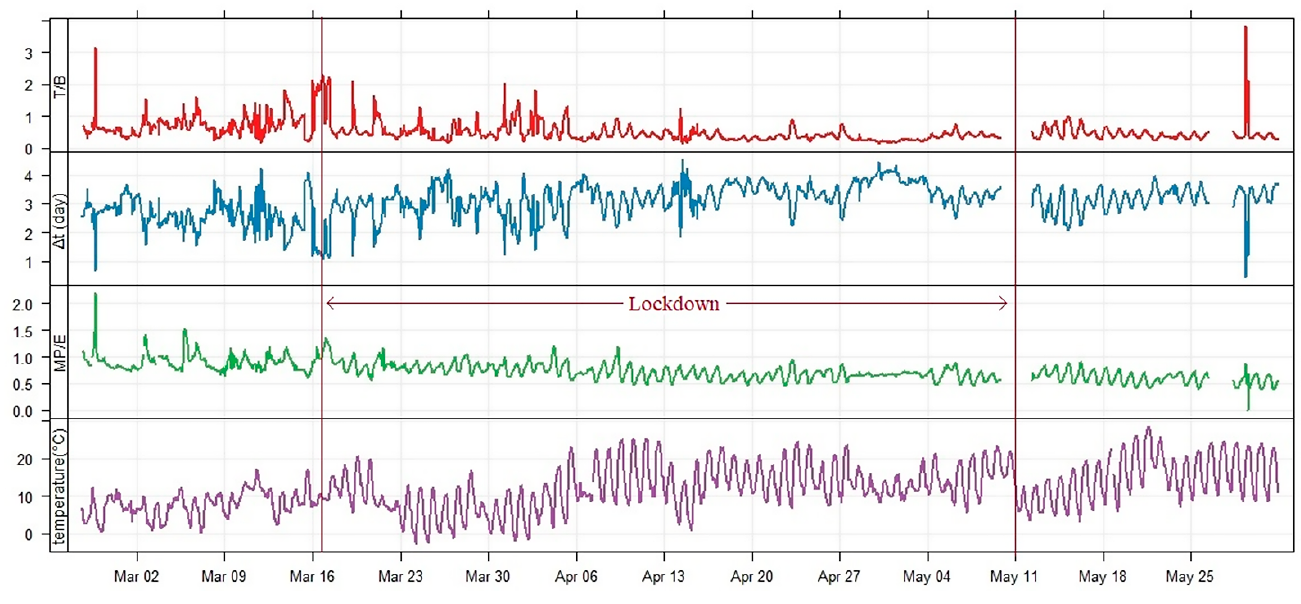
Figure 5. Variation of toluene/benzene (T/B), photochemical age of the air ( ∆ t), m, p-xylene/ethylbenzene (MP/E) concentration ratios and temperature in the observation site during the entire measurement period.